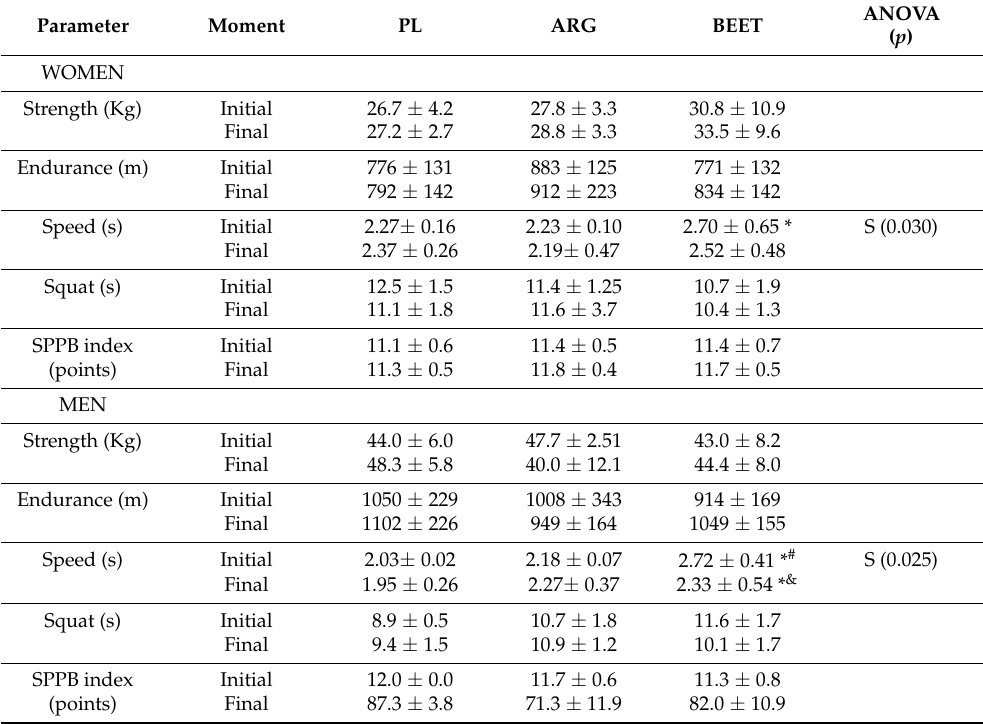
Table 6. Physical activity parameters in the studied